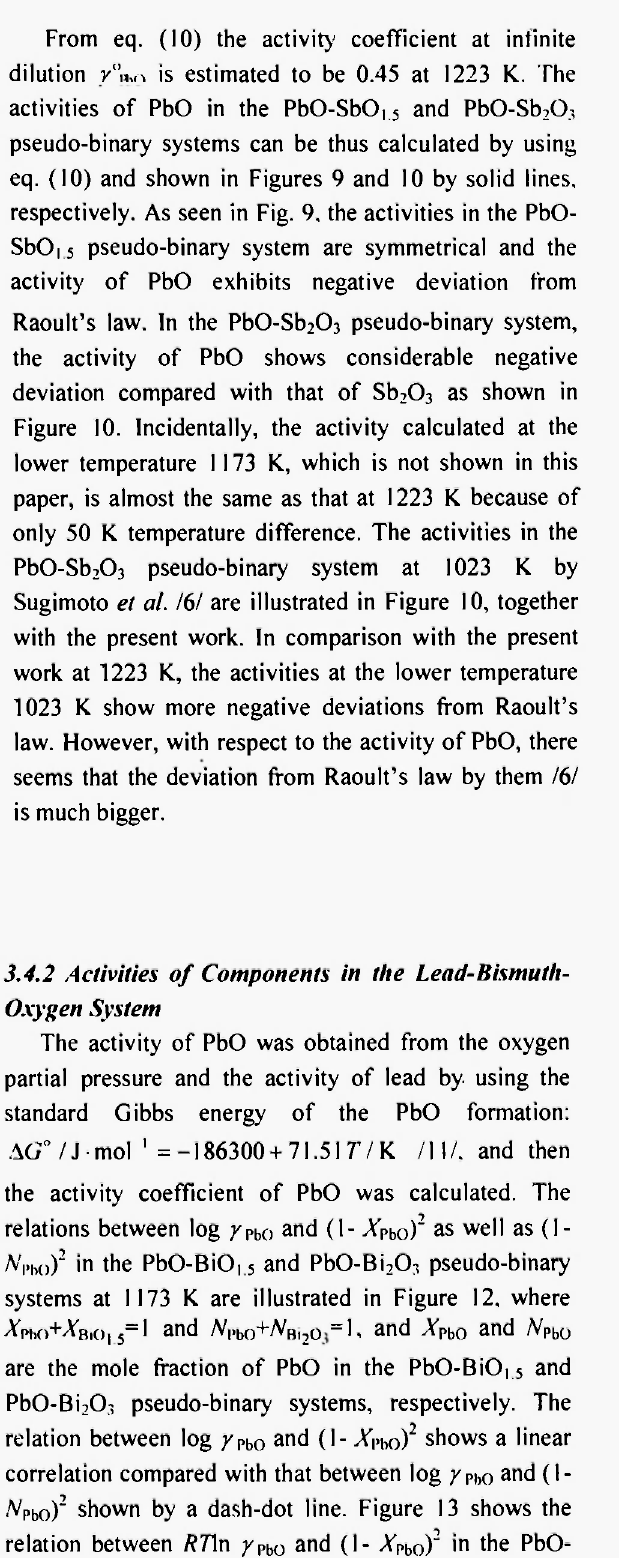
Fig. 13: Relation between /?71n j Pb0 and (l-vf Pb0 ) 2 in the PbO-BiO 1 5 pseudo-binary